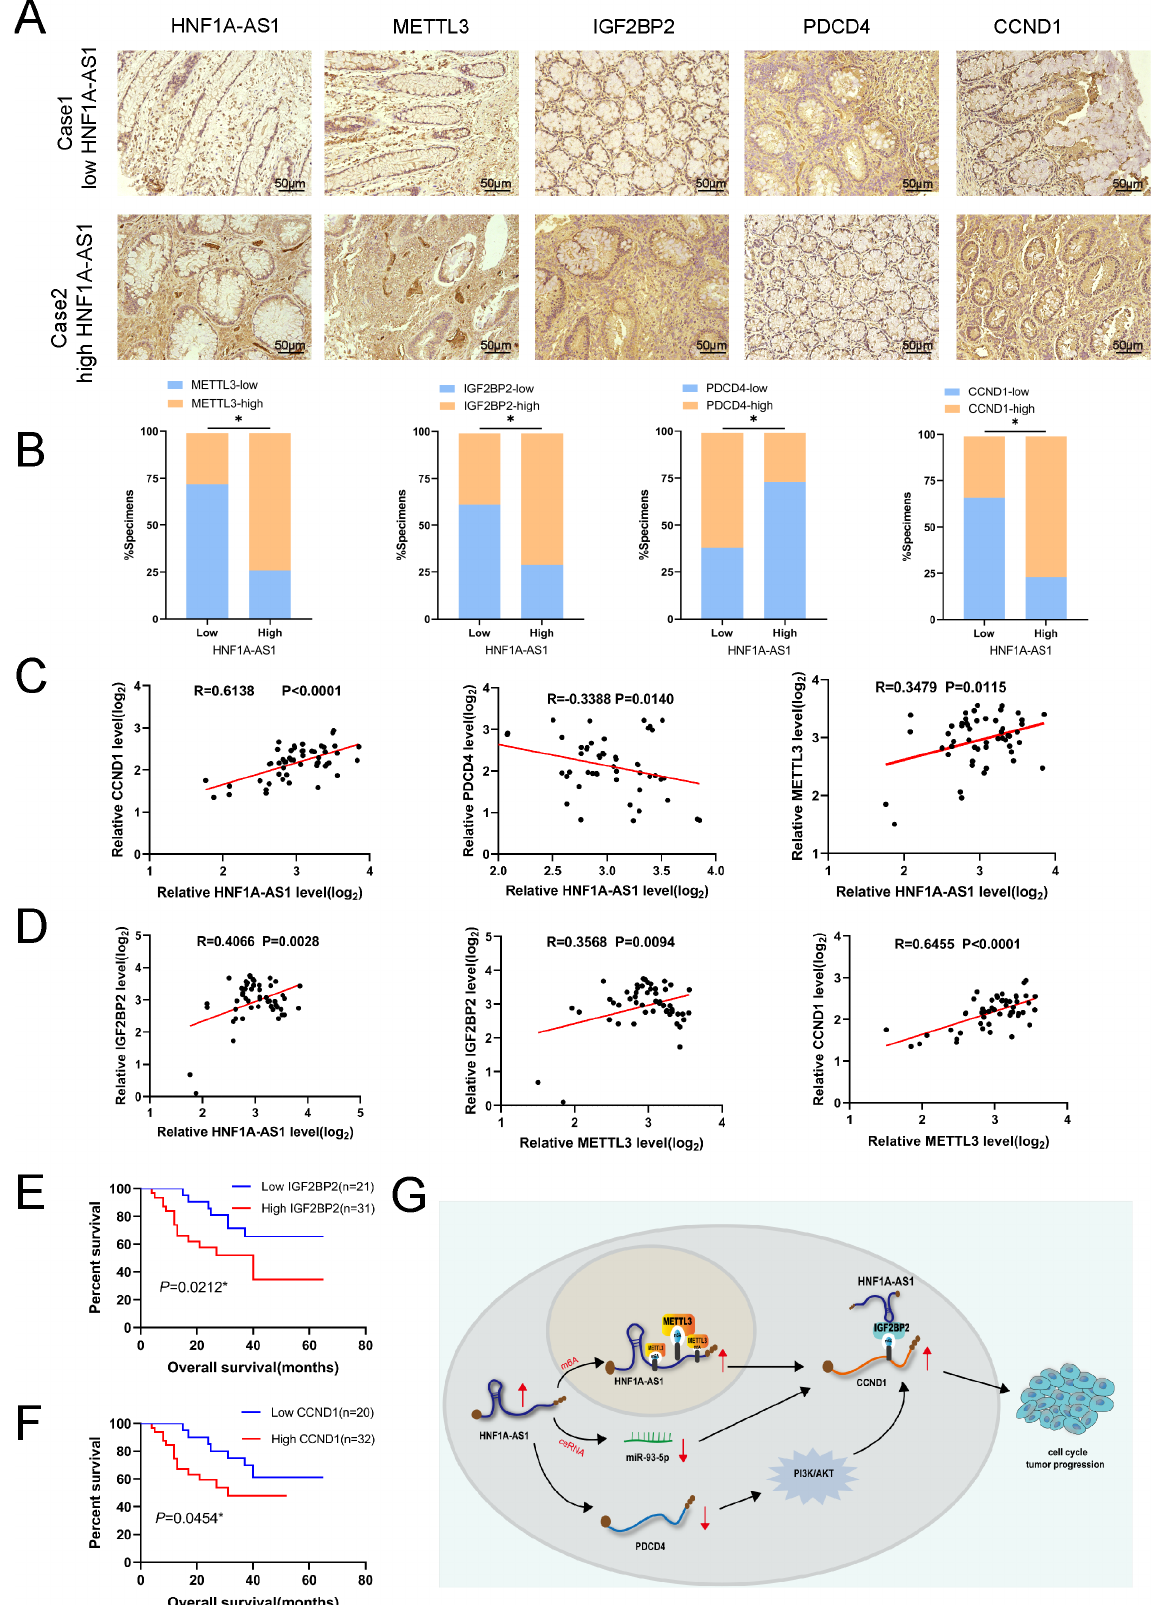
Figure 7. m 6 A/HNF1A-AS1/CCND1 axis cooperated with PDCD4 to regulate PI3K/AKT pathway and related clinical relationship in CRC. ( A ) Representative images showing high or low